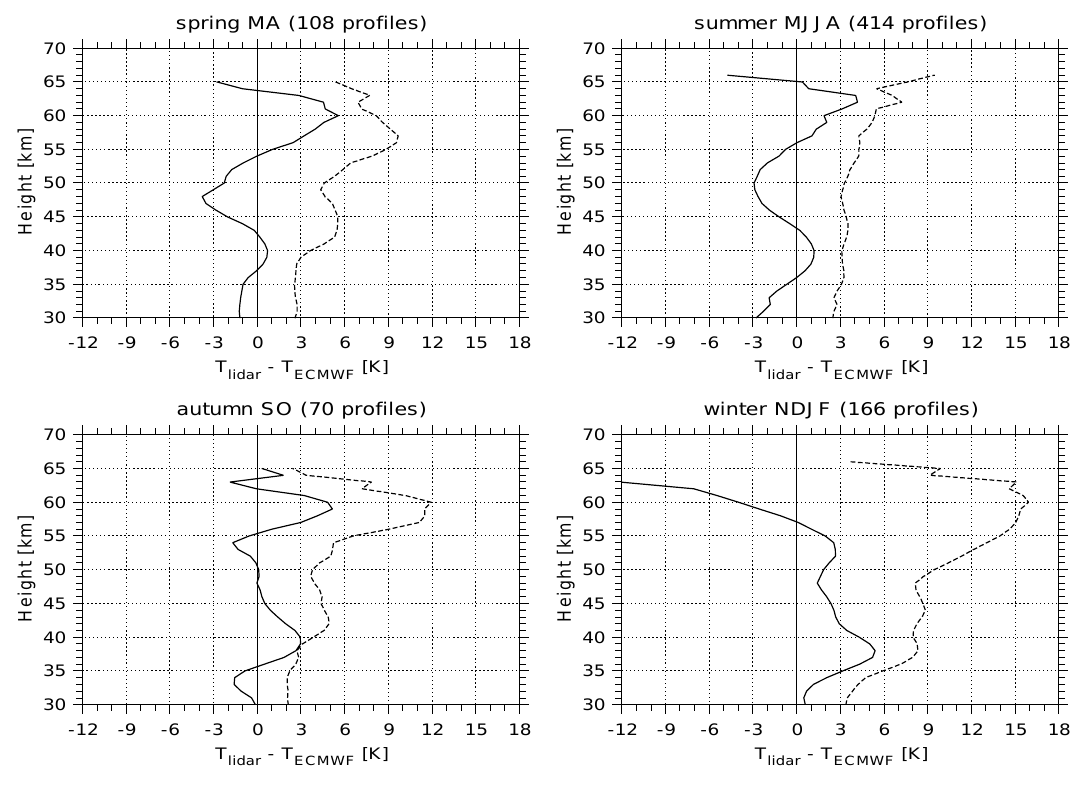
Fig. 7. Statistical analysis of the deviations between RMR lidar observed temperatures and ECMWF operational analyses divided by seasons. Positive mean deviations (solid line) signify heights at which the ECMWF model calculates temperatures that are lower than those observed with the RMR lidar. The dashed lines give the 1- σ range of the